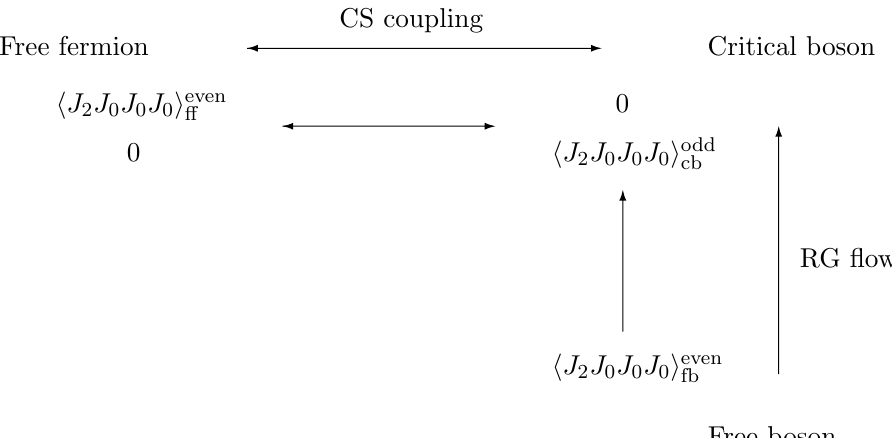
Figure 1 . A schematic description of the duality map among the free fermion ((cid:11)), critical boson (cb) and free boson (fb) theories. We also provide the duality transformations of the correlation functions associated with di(cid:11)erent tensor structures. In a more complete web of the bosonization duality, there is another corner for critical fermion theory, and it relates to solution to the quasi- boson approximate higher spin Ward identity, which is not studied in this